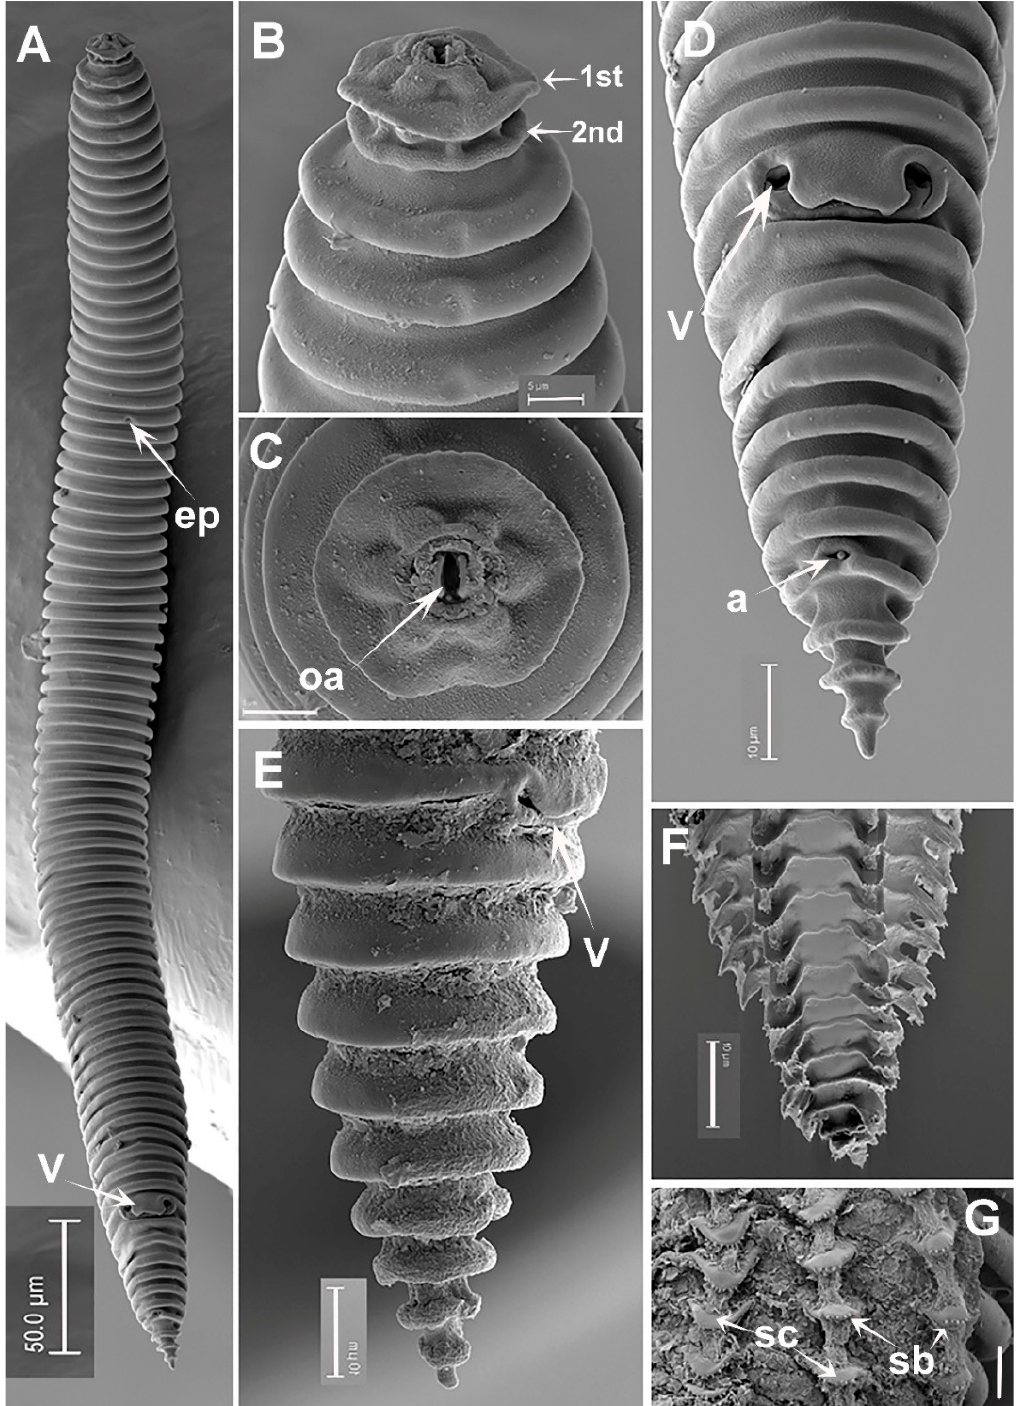
Figure 6. SEM micrographs of Criconema pseudoannuliferum sp. nov. female and fourth-juvenile stage. ( A ), whole female; ( B ), female detail of 1st and 2nd body annuli; ( C ), female en face view showing oral aperture (arrowed); ( D , E ), female posterior region in lateral and frontal views showing vulva and anus (arrowed); ( F , G ), posterior region of fourth-juvenile stage showing files of scales (arrowed) and minute short bristles (arrowed). Abbreviations: a = anus; ep = excretory pore; oa = oral aperture; sb = short bristles; sc = scales; V = vulva; 1st, 2nd = first- and second-body annuli. Scale bars: ( A ) = 50 µm; ( B , C ) = 5 µm; ( D – F ) = 10 µm; ( G ) = 5 µm. Table 3. Morphometrics of Criconema pseudoannuliferum sp. nov. from the rhizosphere of maritime pine ( Pinus pinaster Ait.) in Casares, Málaga province, Spain.